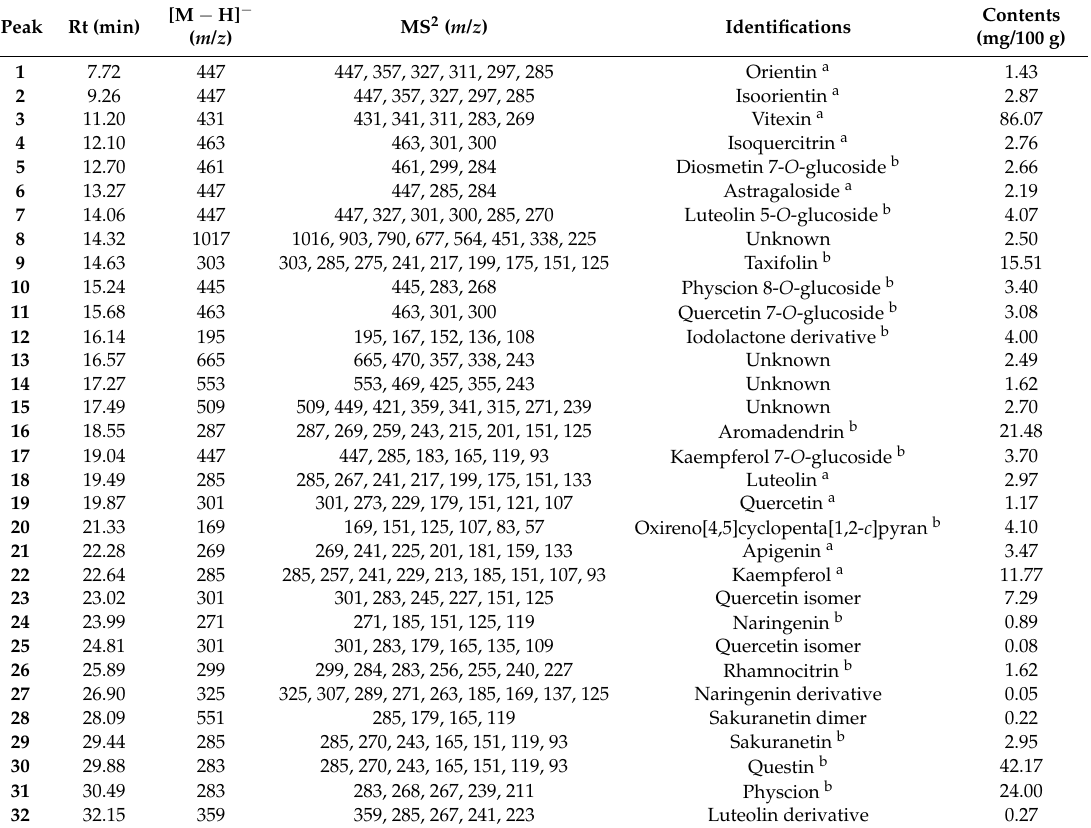
Table 1. Identification and quantitative analysis of flavonoids and other compounds corresponding to the chromatographic peaks in Figure 1 by HPLC-ESI-MS/MS.